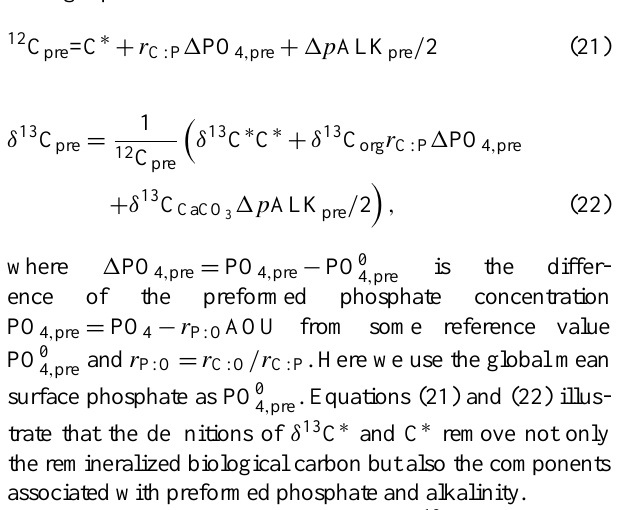
only δ 13 C org , no-bio = δ 13 C org , fast-gasx-only = mean( δ 13 C DIC ( z = 0 : 100 m)) = 2